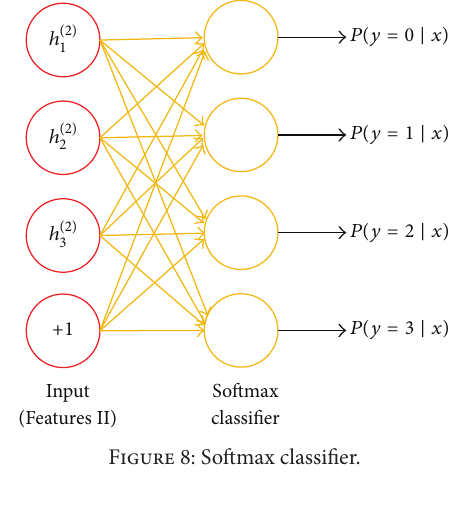
Figure 8: Softmax classifier.